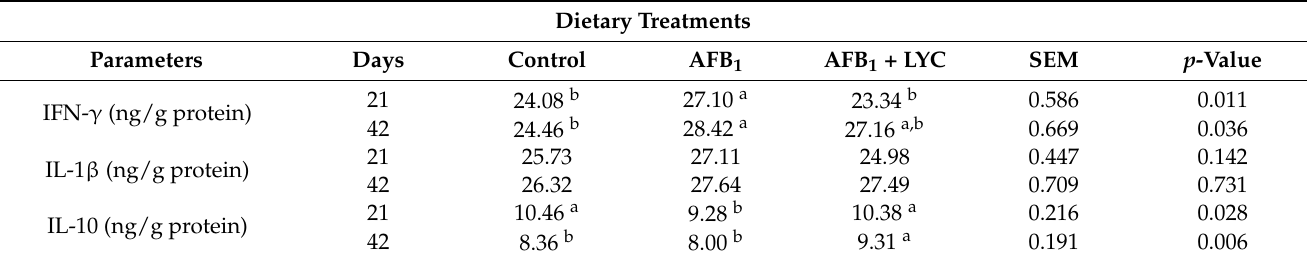
Table 3. Effects of LYC on mucosal inflammatory status in the broiler jejunum fed AFB 1 contaminated diet at 21 and 42 d. Dietary Treatments Parameters